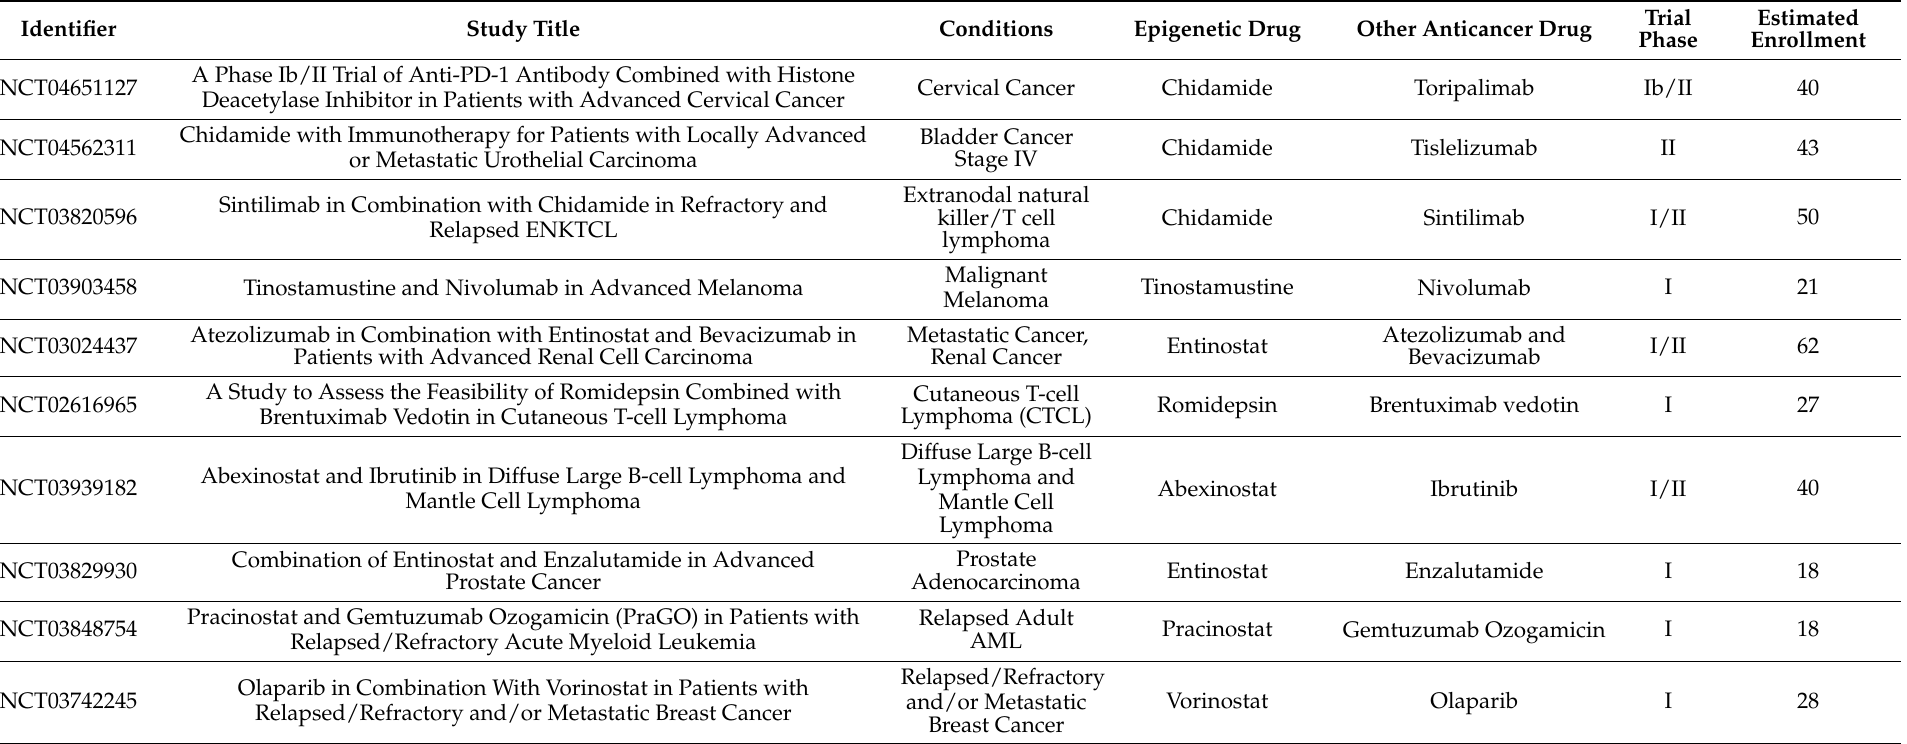
Table 2. Ongoing (recruiting or not yet recruiting) clinical trials of combined epigenetic drug (HDACi) and other anticancer therapeutic agents (e.g., chemotherapy and